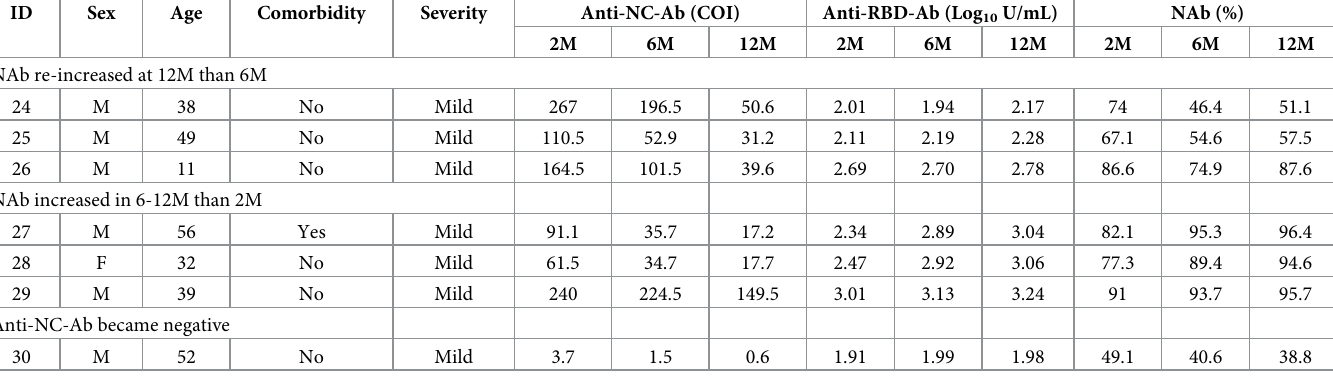
Anti-NC-Ab: anti-nucleocapsid antibody, � 1.0 COI (cut-off index) is positive; Anti-RBD-Ab: anti-receptor binding domain antibody, � –0.0969 Log 10 U/mL ( � 0.8 U/ml) is positive; NAb: neutralizing antibody, � 30% (% of inhibition) is positive; 2M: 2 to 3 months after the COVID-19 outbreak in the workplace; 6M: 6 months after the outbreak; 12M: 12 months after the outbreak; Mild: no pneumonia; Moderate: pneumonia not requiring